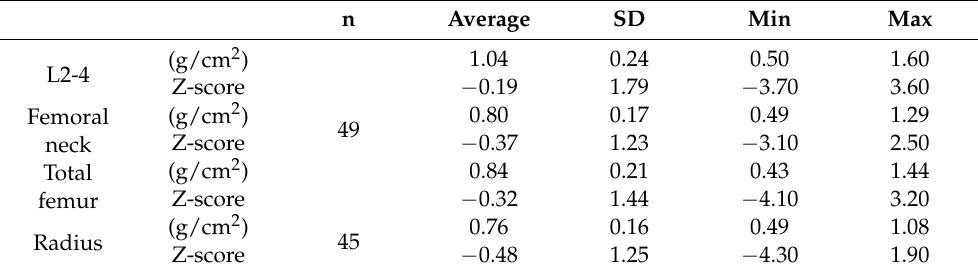
Table legends: min: minimum; max: maximum; BMI: body mass index; CLR: clavicle cortical bone length ratio; SD: standard deviation. Results of the DXA and Z-scores obtained from the DXA are shown in Table 2. The study population showed an average Z-score less than zero in all four regions of the DXA measurement. Table 2. BMD measured by DXA with Z-scores.